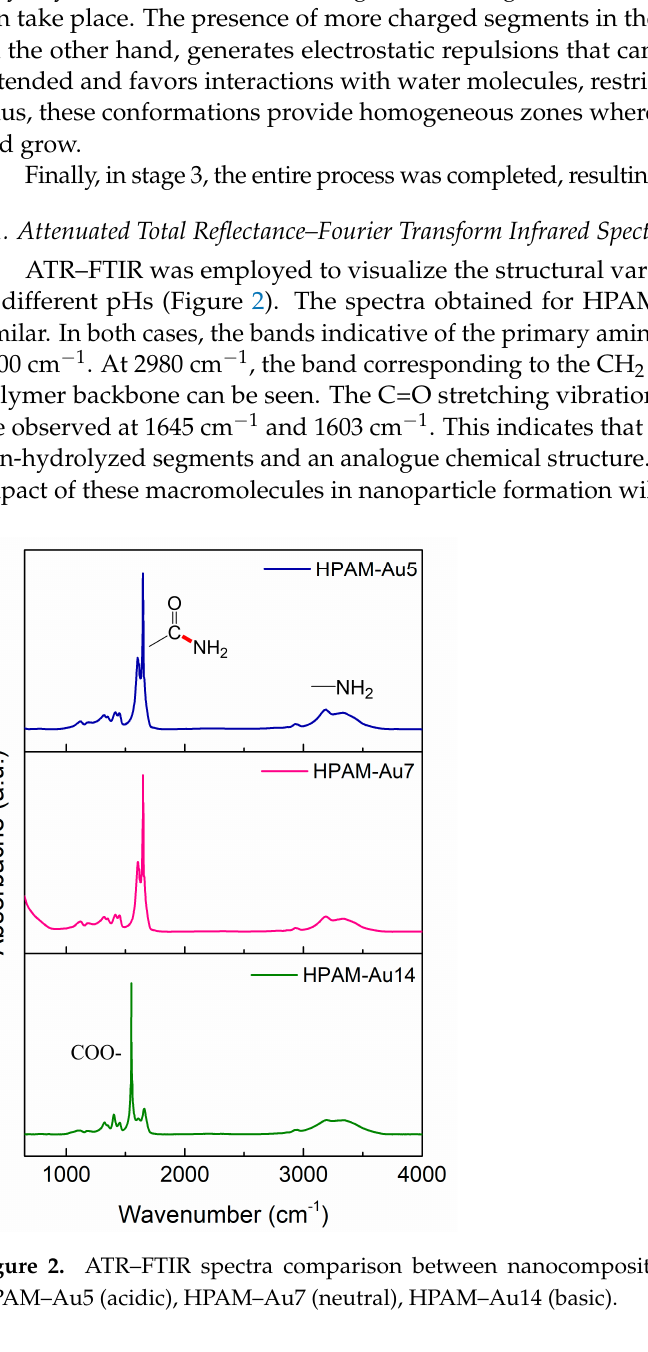
Table 1. Molecular weight values of nanocomposites. Sample